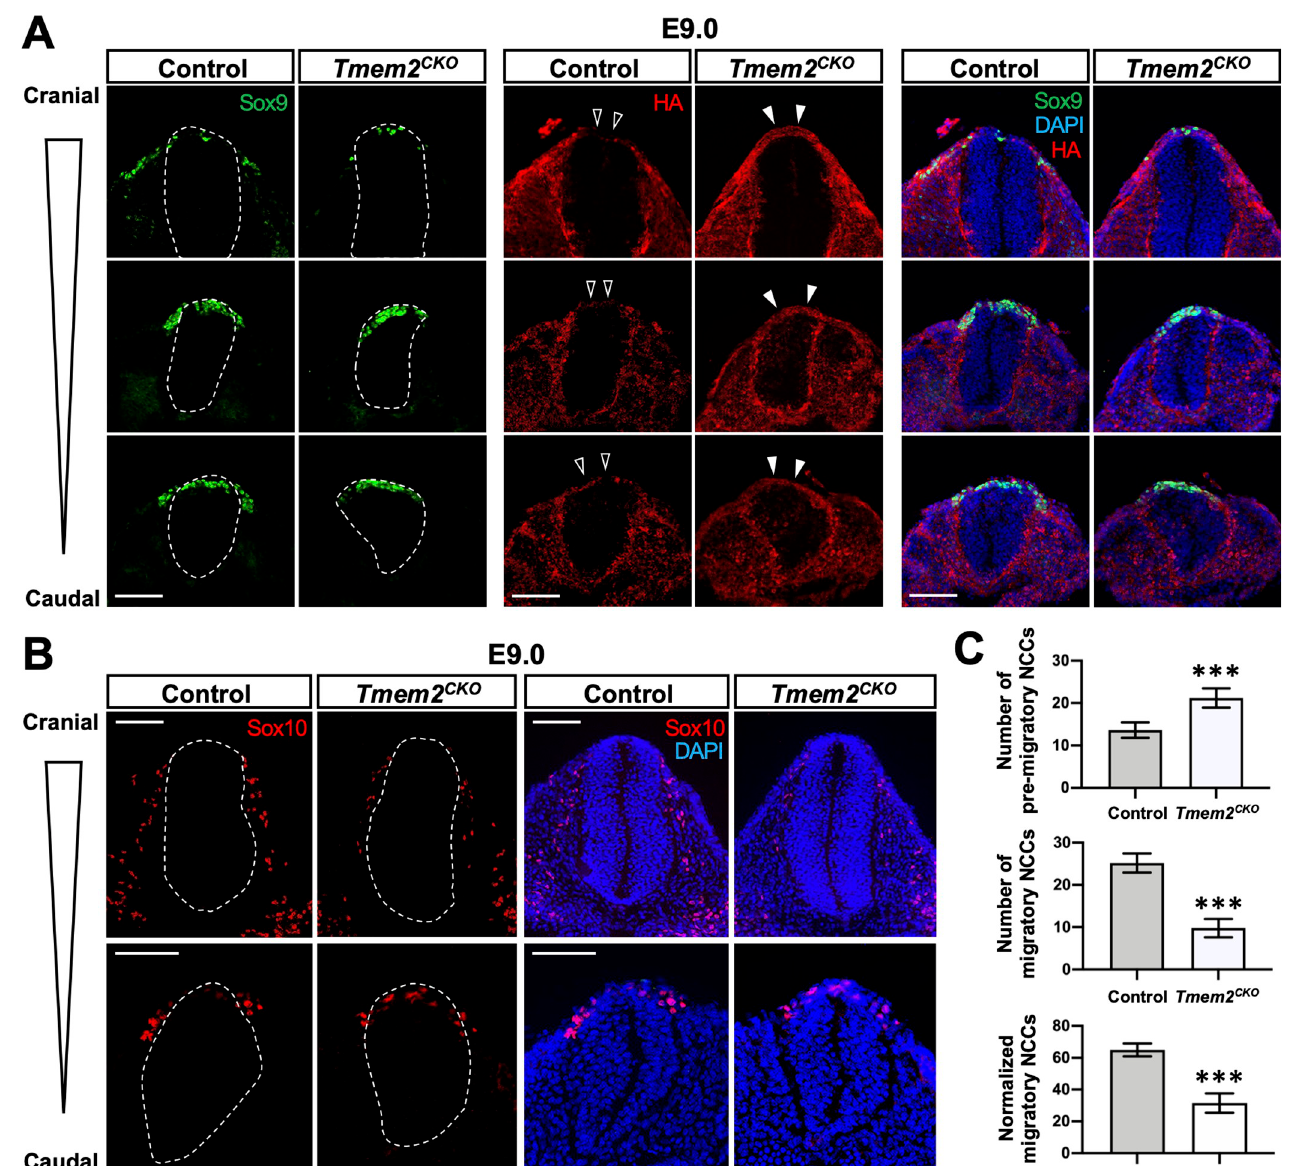
Fig 3. Effects of Tmem2 ablation on NCC development. ( A ) Transverse sections at three different levels of the neural tube of Tmem2 CK O and control embryos at E9.0 were triple-stained for Sox9 ( green ), HA ( red ), and nuclei ( blue ). Broken lines indicate the external contour of the neural tube. Note that emigration of Sox9-positive cells out of the neural tube is reduced in Tmem2 CK O embryos. Also, in Tmem2 CK O embryos, the dorsal surface of the neural tube exhibits HA staining ( filled arrowheads ), whereas little HA staining is detectable in the corresponding area of control embryos ( open arrowheads ). ( B ) Transverse sections of Tmem2 CK O and control embryos at E9.0 were double-stained for Sox10 ( red ) and nuclei ( blue ). In Tmem2 CKO embryos, the number of Sox10-positive cells outside of the neural tube is significantly decreased. The image in the caudal neural tube reveals that some Sox10-positive cells persist within the neural tube in Tmem2 CKO embryos. ( C ) Quantification of pre-migratory and migrating NCCs in Tmem2 CKO and control embryos. The numbers of Sox9-positive cells within the neural tube and Sox10-positive cells outside of the neural tube were counted as pre-migratory and migrating NCCs, respectively ( top and middle bar graphs ). The ratio of migratory NCCs relative to the total number of NCCs was also compared between Tmem2 CKO and control embryos ( bottom graph ). Data represent means ± SD ( n = 5). ��� p < 0.001 by Student’s t -test. Scale bars, 300 μ m in A and B . ZsGreen embryos (Fig 4B, middle panels ). In Tmem2 CKO ;ZsGreen embryos, the contribution of ZsGreen-positive cells to trunk neural tube-derived dorsal root ganglia is reduced ( Fig 4C, arrowheads ), whereas ZsGreen-positive cells within the neural tube are increased in number